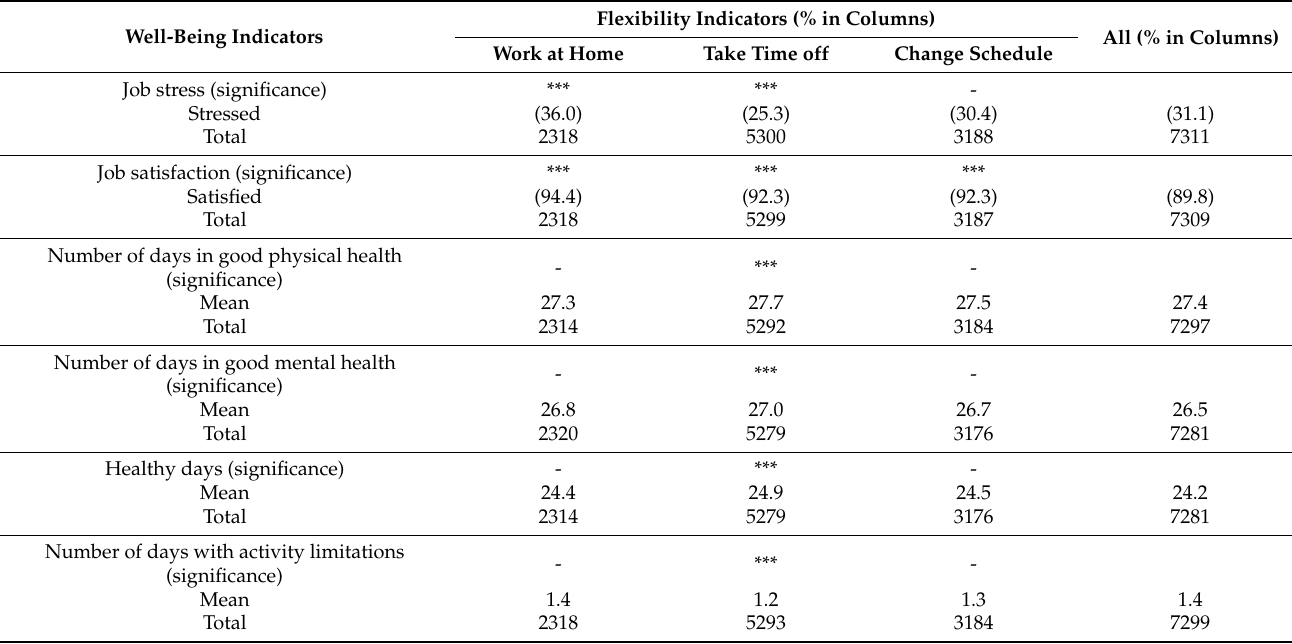
Table 2. Well-being by flexibility indicator, pooled GSS-QWL